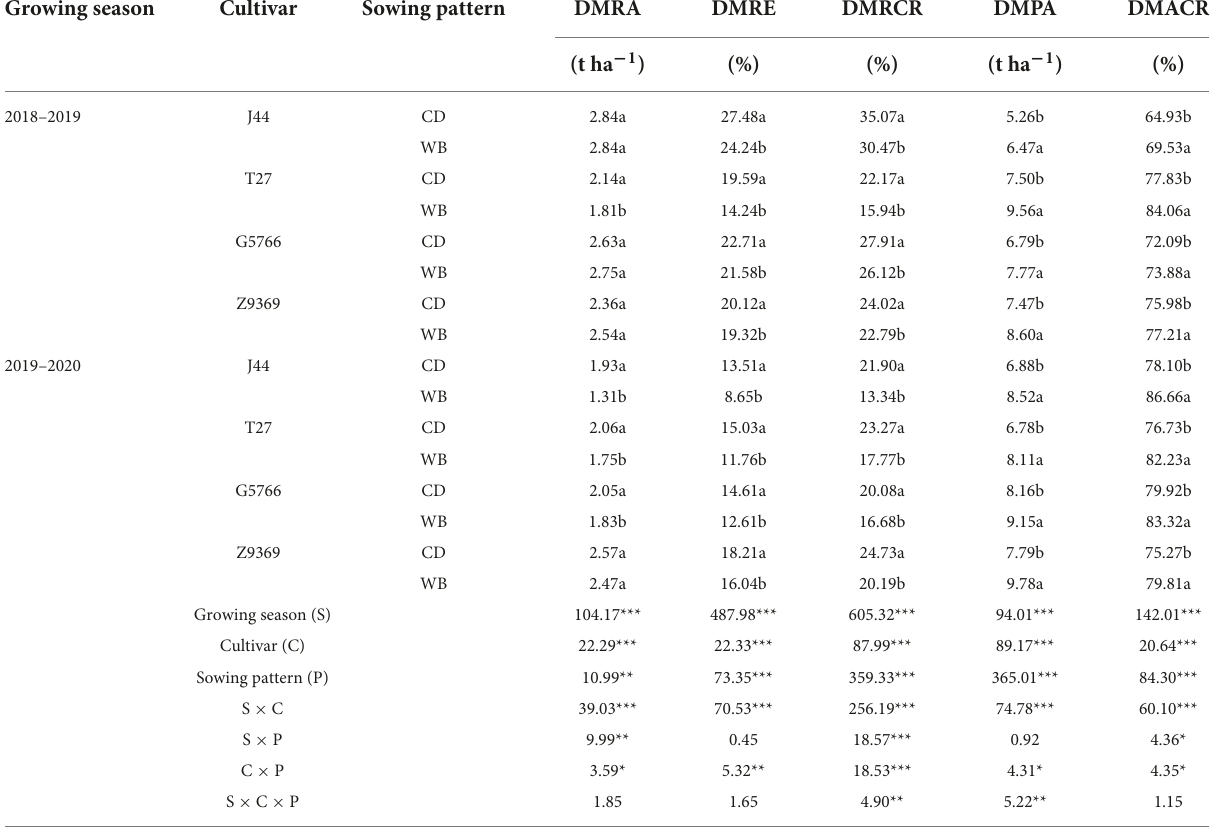
TABLE 3 Effects of sowing pattern on the dry matter remobilization, production, and contribution rate to grain dry matter of bread wheat. Growing season